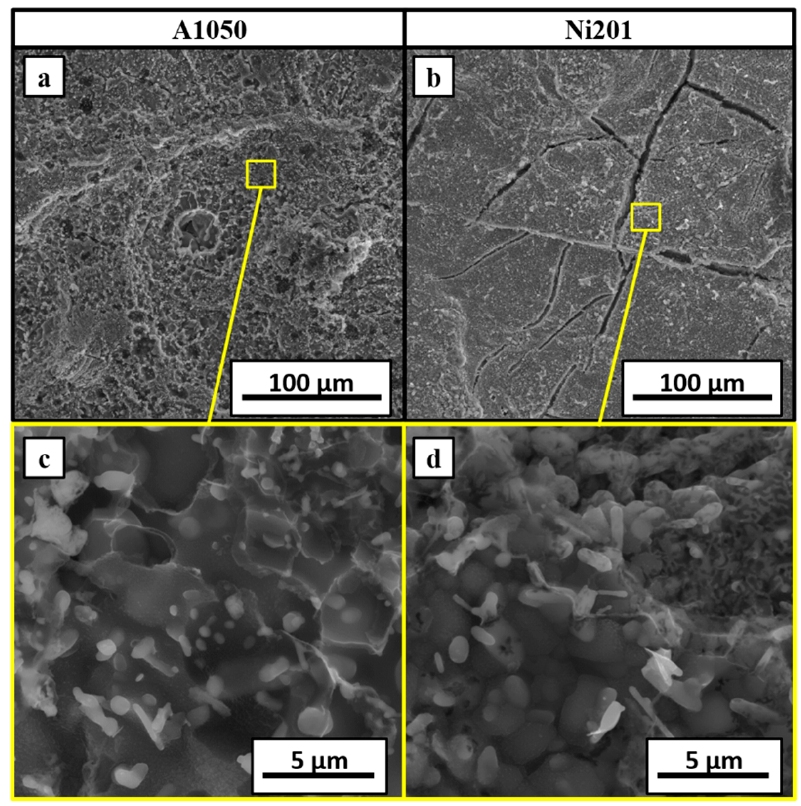
Figure 11. SEM-SE images of the surfaces’ fractures of A1050 ( a , c ) and Ni201 ( b , d ) side of EXW Ni201/A1050 clad manufactured at V d = 2000 m/s and annealed at 500 °C for 168 h after disintegration.